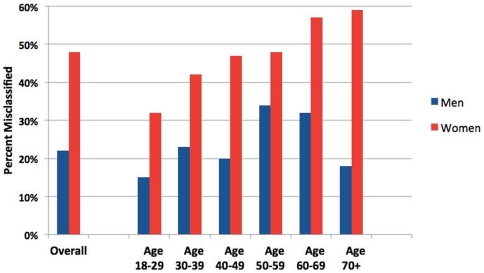
Percent Misclassified as Non-obese by BMI Statified by Age, and Sex (n = 539).Women demonstrate clear correlation between advancing age and increasing percent misclassification, with over half misclassified by age 60–69. This association is not apparent for men.